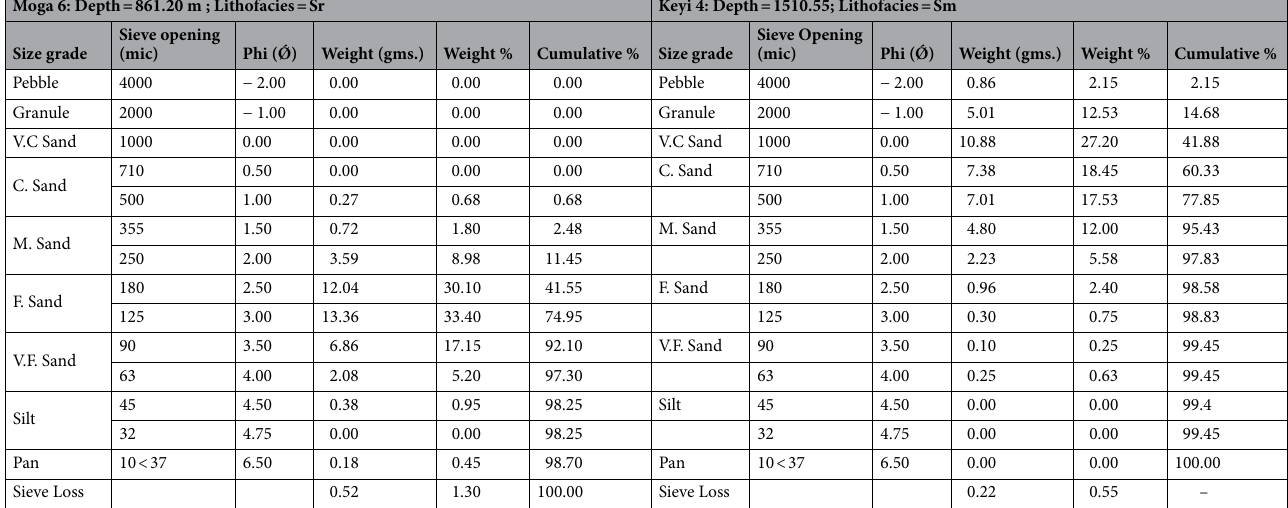
Table 3. Grain size analysis result. Moga 6:Granulometric composition ( Sample Depth: 860.70 m; Total Weight: 40 g; Facies Code: Sr ) . Gravel: 0.00%. Sand: 98.57%. Mud: 1.42%. Sample description ( Fine sand, moderately sorted, near—symmetrical, leptokurtic). Keyi 4: Granulometric composition (Sample Depth: 1510.55 m; Total Weight: 40 g; Facies Code: Sm). Gravel: 14.76%. Sand: 85.23%. Mud: 0.00%. Sample description (Coarse sand, poorly sorted, near—symmetrical,